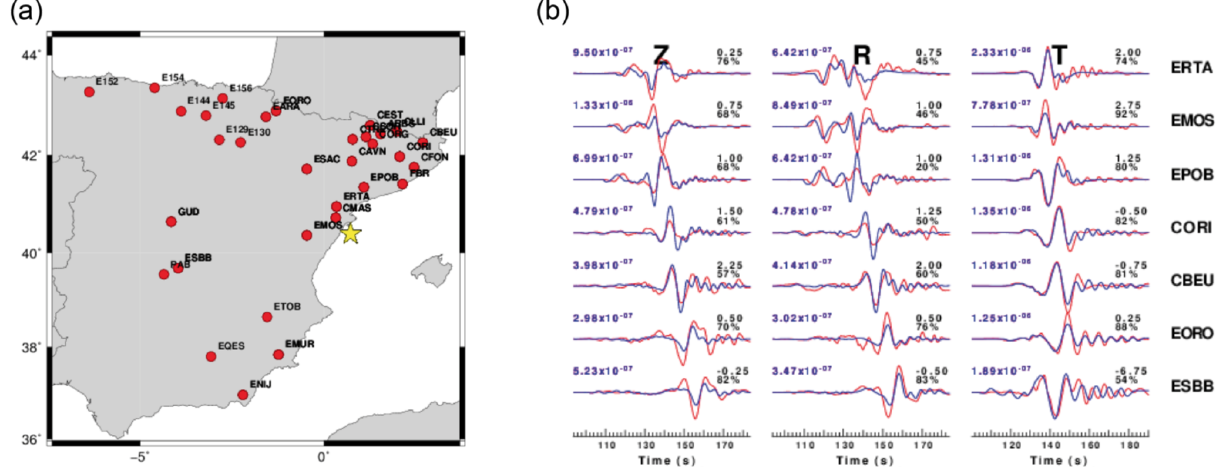
Figure 4. Regional moment tensor determined for the largest earthquake of the sequence, which occurred on 1 October 2013, 03:32UTC, with M w = 4 . 08. (a) Location of the earthquake (yellow star) and of broadband stations that were used to determine this moment tensor (red circles). (b) Waveform fits for the optimum solution of the moment tensor for this earthquake. Z indicates vertical component, R radial, and T transverse. Observed (red) and predicted (blue) ground velocities for the optimum solution are shown for seven selected